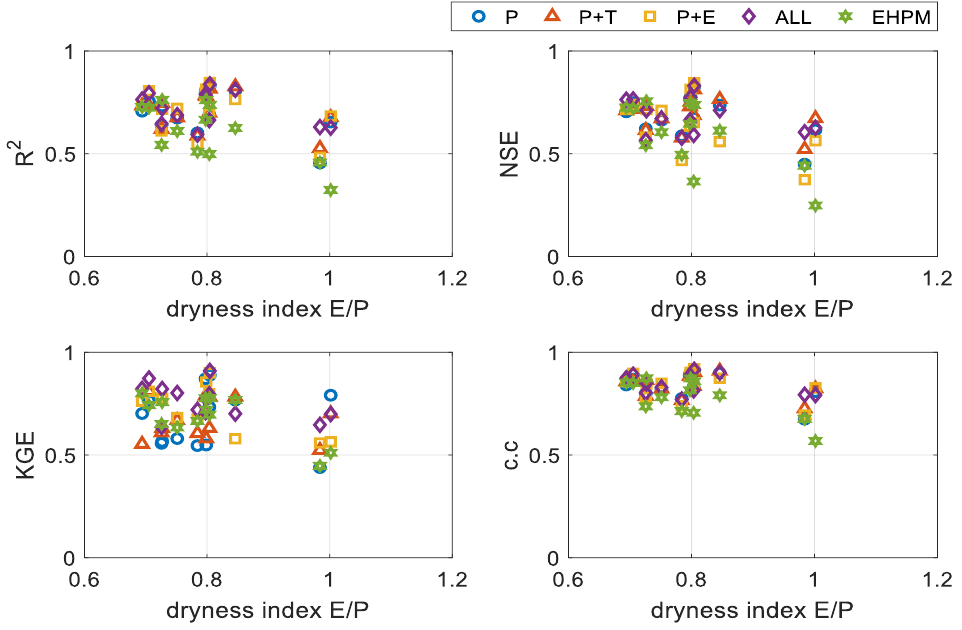
Figure 6. Distribution of each performance metric for dry